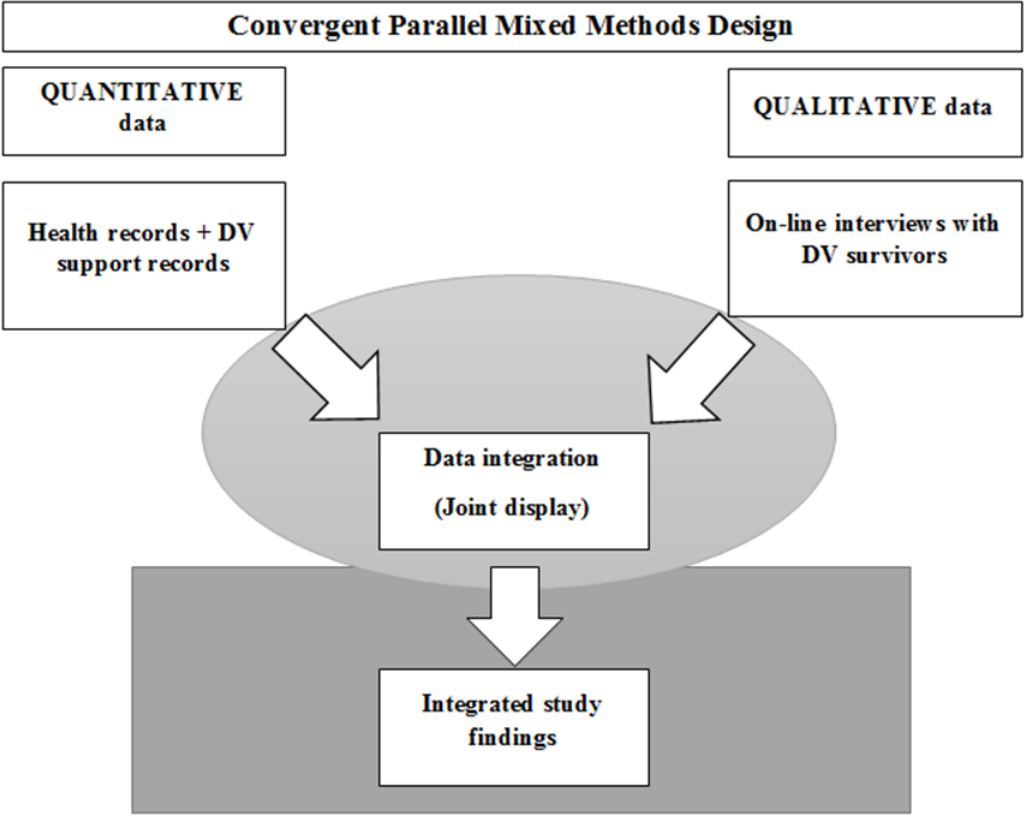
Figure 1. Schema for the mixed-methods research design.